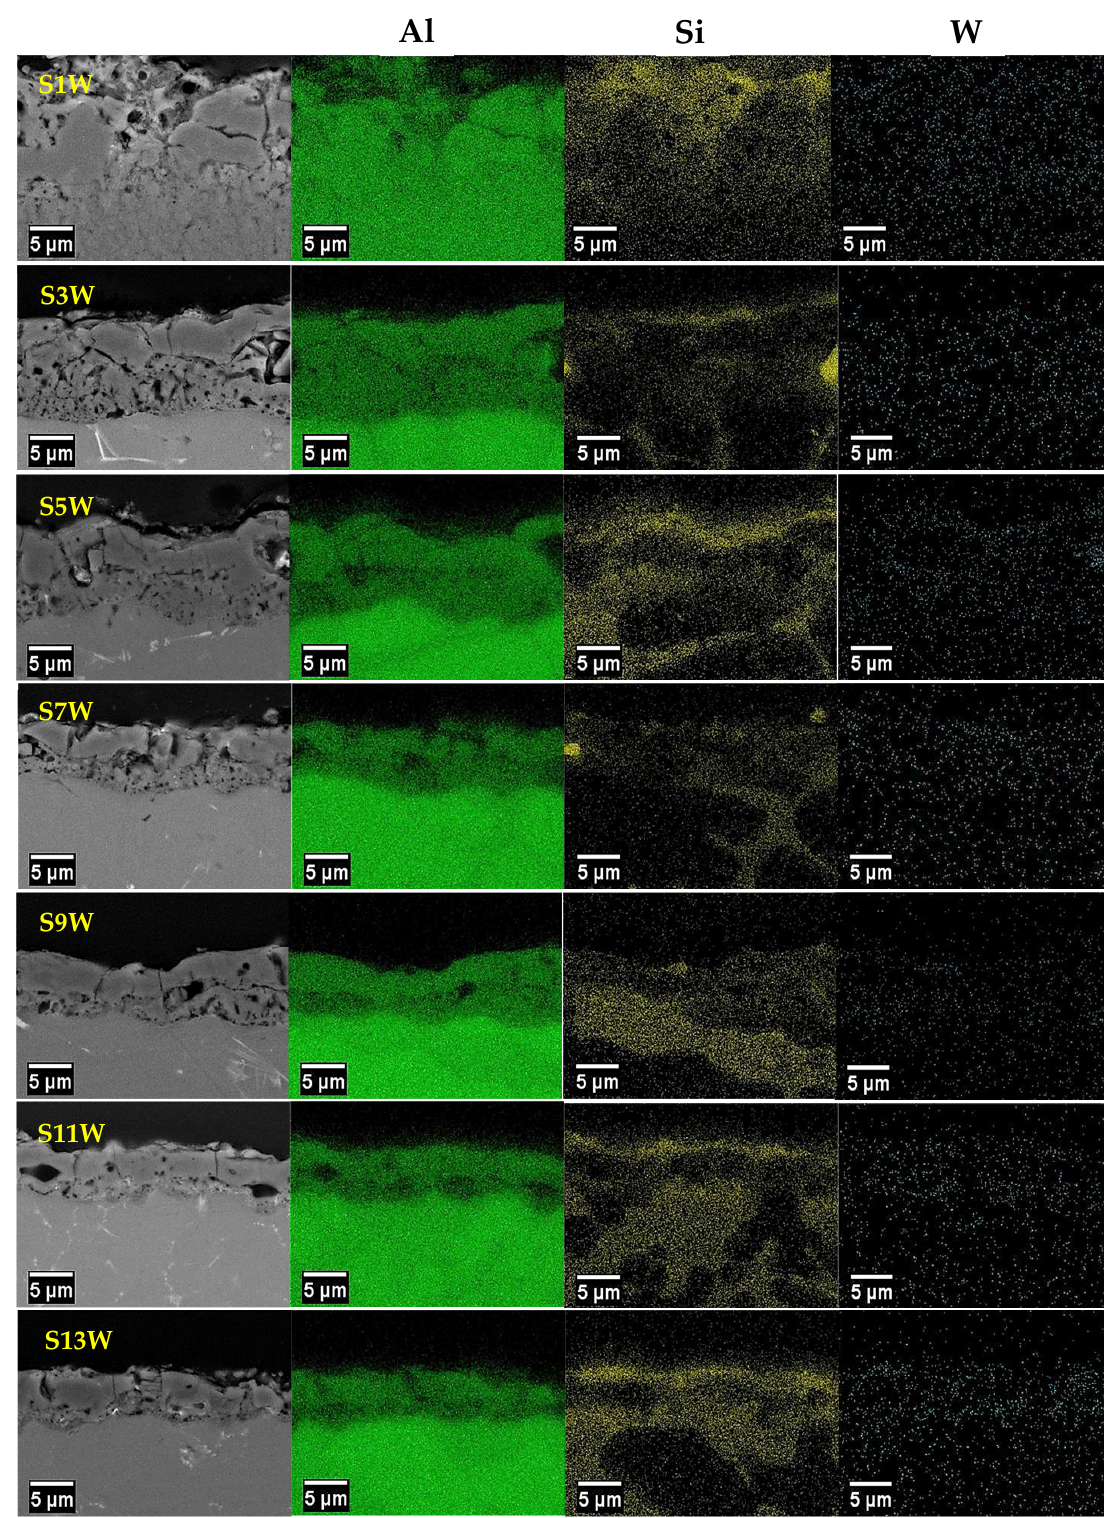
Figure 10. The elemental map of the cross-section of the PEO specimens prepared by the silicate- based electrolyte containing Na 2 WO 4 that consists of Al, W, and Si elements, denoted by green, blue, and yellow, respectively.